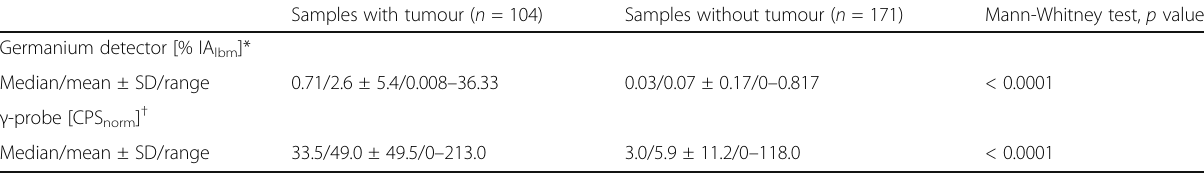
Table 3 γ -probe and germanium detector measurements from 275 tissue samples of 275 subregions Samples with tumour ( n =